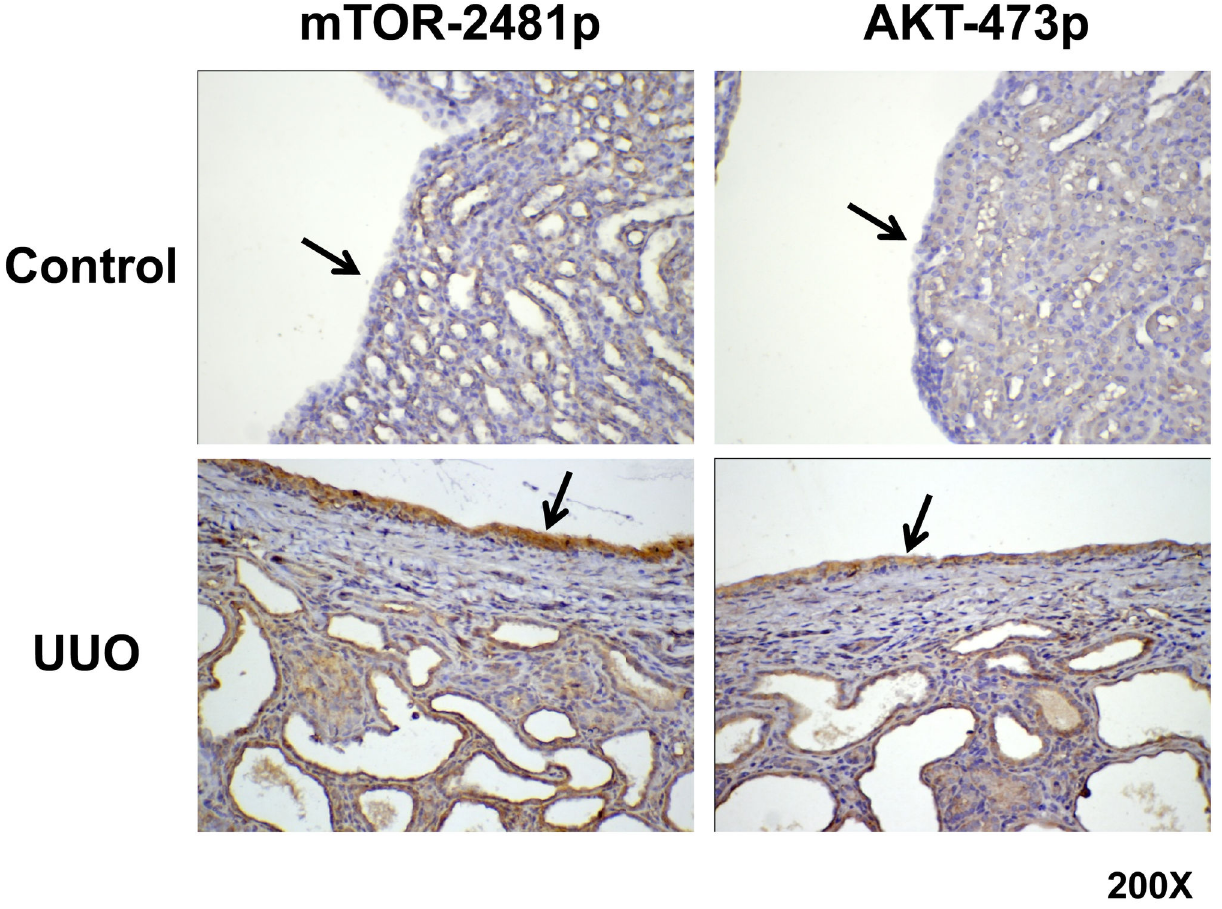
Figure 5. Hydronephrotic urine induced the phosphorylation of mTOR-Ser2481 and AKT-Ser473 in rat kidney after 3 weeks of UUO. The phosphorylation of mTOR-Ser2481 and AKT-Ser473 in normal rat kidney and rat kidney after 3 weeks of UUO was analyzed by immunohistochemistry stain (200X). Arrows indicate the urothelial cell layer in kidney. doi: